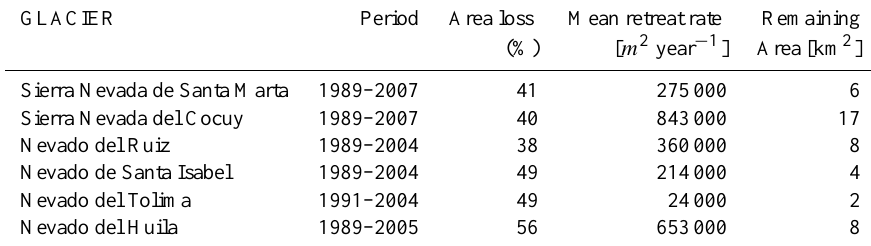
Table 3. Summary of identified Colombia’s estimated glaciers retreat rates and remaining areas. GLACIER Period Area loss Mean retreat rate Remaining